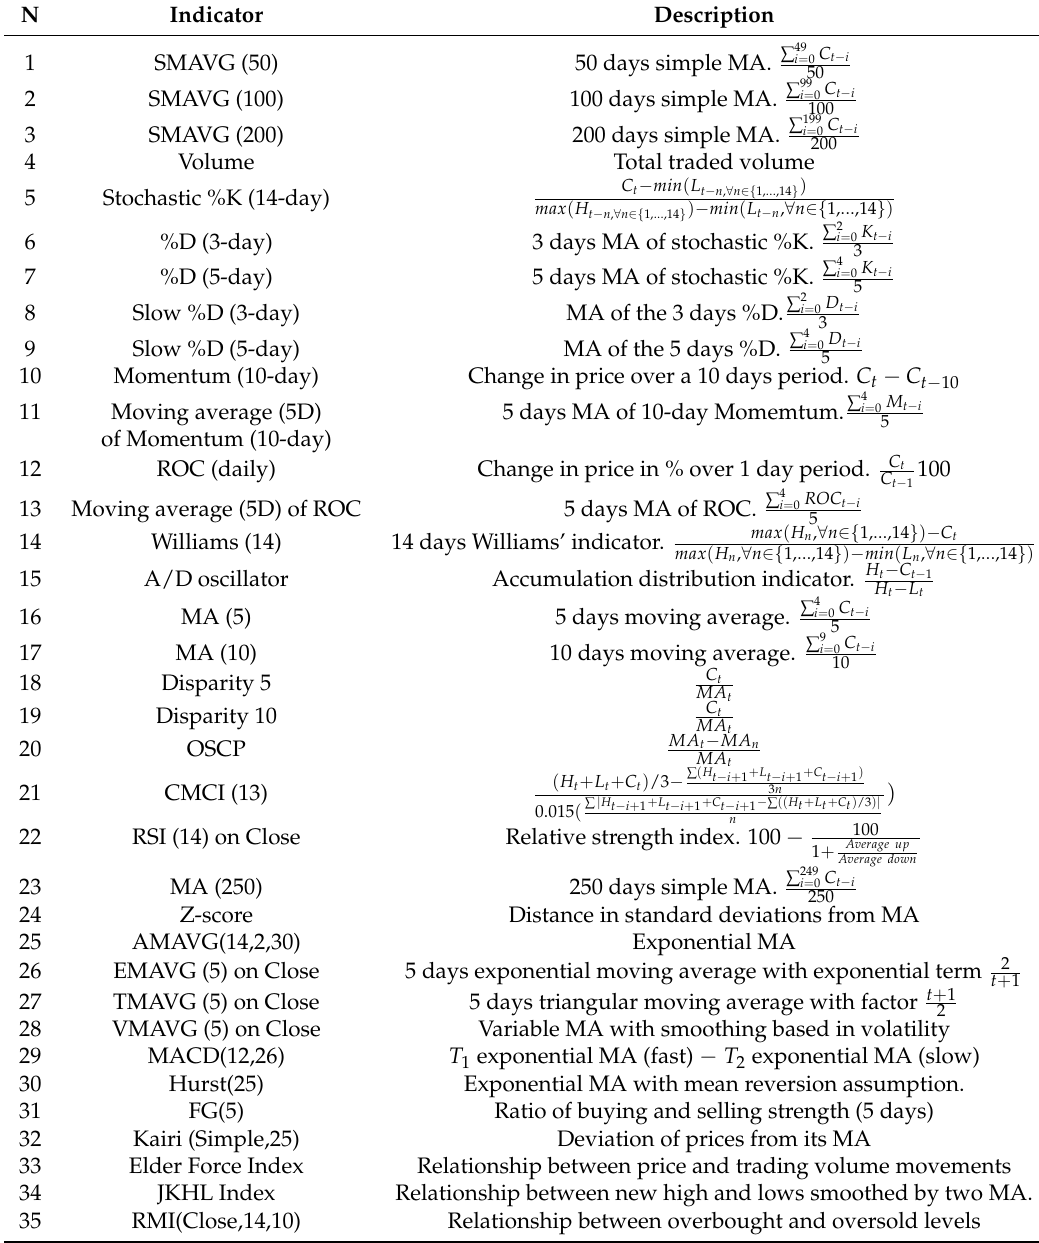
Table 2. Technical indicators. C t denotes the current price and L t and H t are the minimum and maximum prices in period t and MA means moving average. The exact formulas for some of the indexes are proprietary with the indicators for specific stocks obtainable from databases such as Bloomberg. Source: Blomberg, Kim